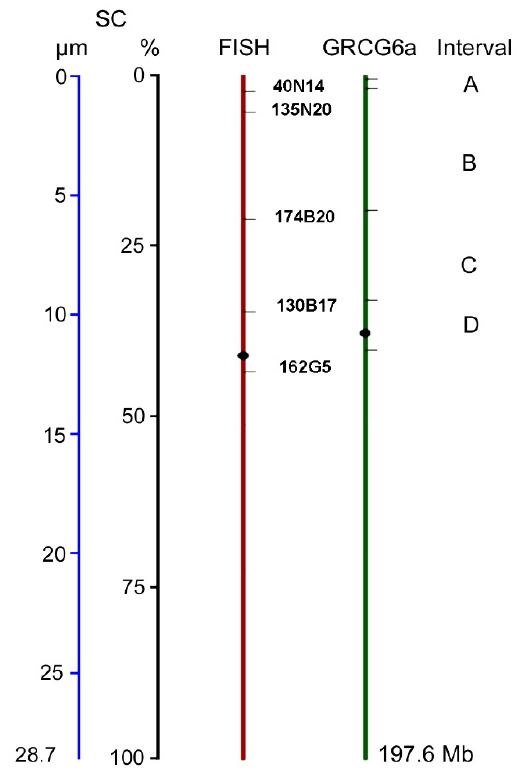
Figure 4. Comparative positions of the BAC clones on the SC and the GGA1 assembly (GRCG6a). The average position of the FISH signals on SC1 (red line) are compared to the relative positions in the chromosome assembly (green line). For the signals on the SC both, absolute ( µ m) and relative (%), positions are shown, with the scales for these positions depicted in blue and black, respectively. The positions of the BAC-clones are shown as relative positions respect to the whole length of GGA1 assembly (197 Mb). The letters A–D are the intervals between BACs. Numerical data for this representation can be found in the Supplemental online material (Table S2). Table 2. Positions of the BAC clones along GGA1 (GRCg6a) and the SC1 (BAC-FISH).